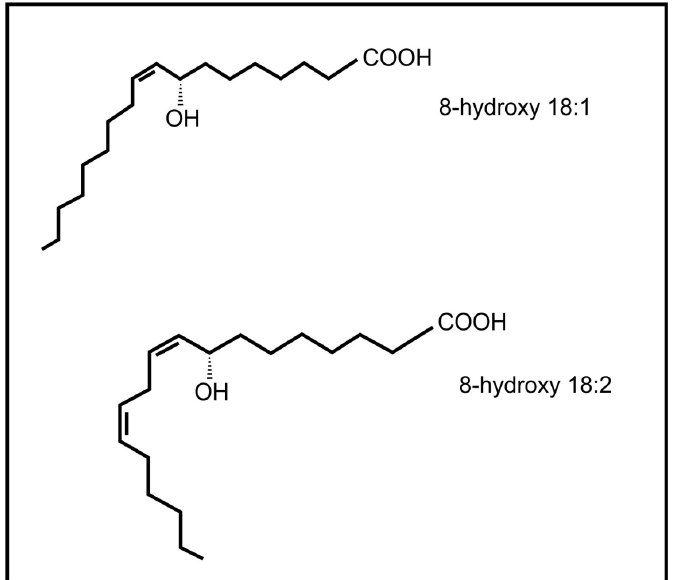
Figure 6. Fungal oxylipins involved in communication with